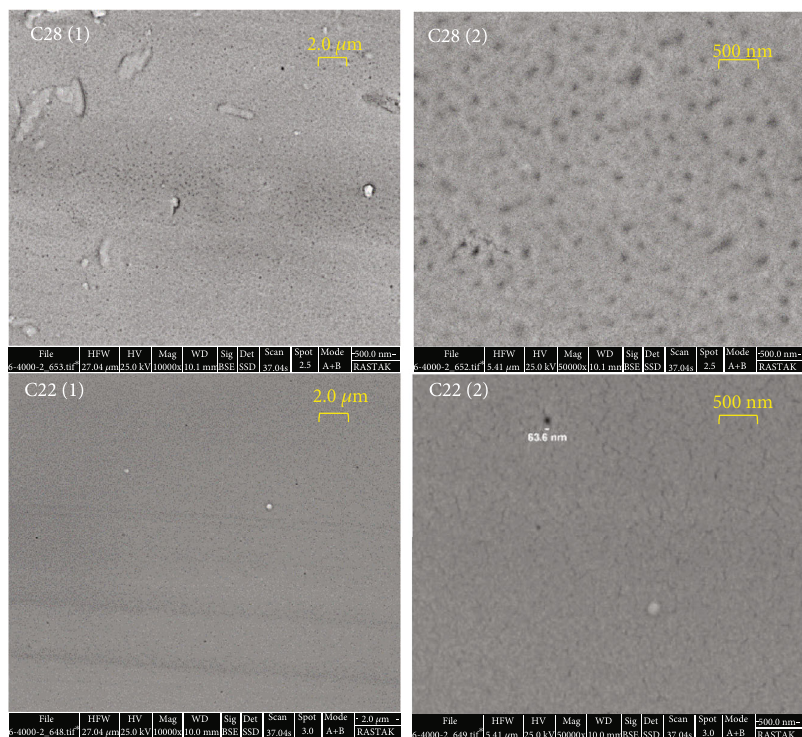
Figure 10: E ff ect of coagulation bath temperature on outer surface morphologies of PAN hollow fi bers: (1) 10000x magni fi cation; (2) 50000x magni fi cation (C22: 22 ° C, C28: 28 ° C).